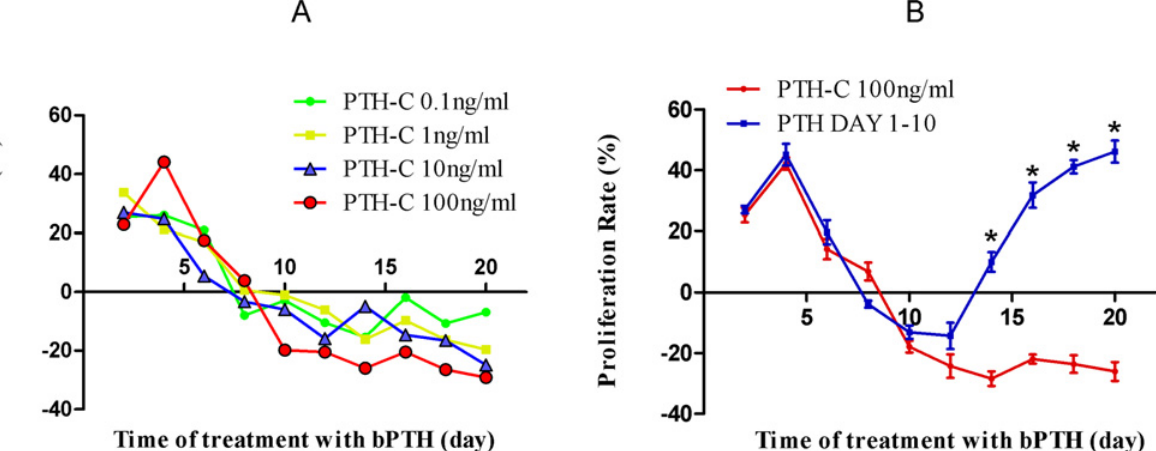
Fig 1. Effects of PTH withdrawal on osteoblast proliferation. Cells were grown in microtiter plates in a final volume of 200 μ L culture medium per well for 2 – 20 days. MTT assays were performed after 48 h. (A) Cell proliferation appears to be downregulated in the first 8 days, and inhibited after 10 days of culture in the continuously-treated bPTH groups. The effect of inhibition increases with the concentration of bPTH. (B) Although osteoblast proliferation coordinately declined in the PTH-C 100 ng/mL and PTH Day 1 – 10 groups, it rebounded after bPTH withdrawal in the PTH Day 1 – 10 group. * Significantly different compared to the PTH-C 100 ng/mL group at the same time point, P < 0.05.